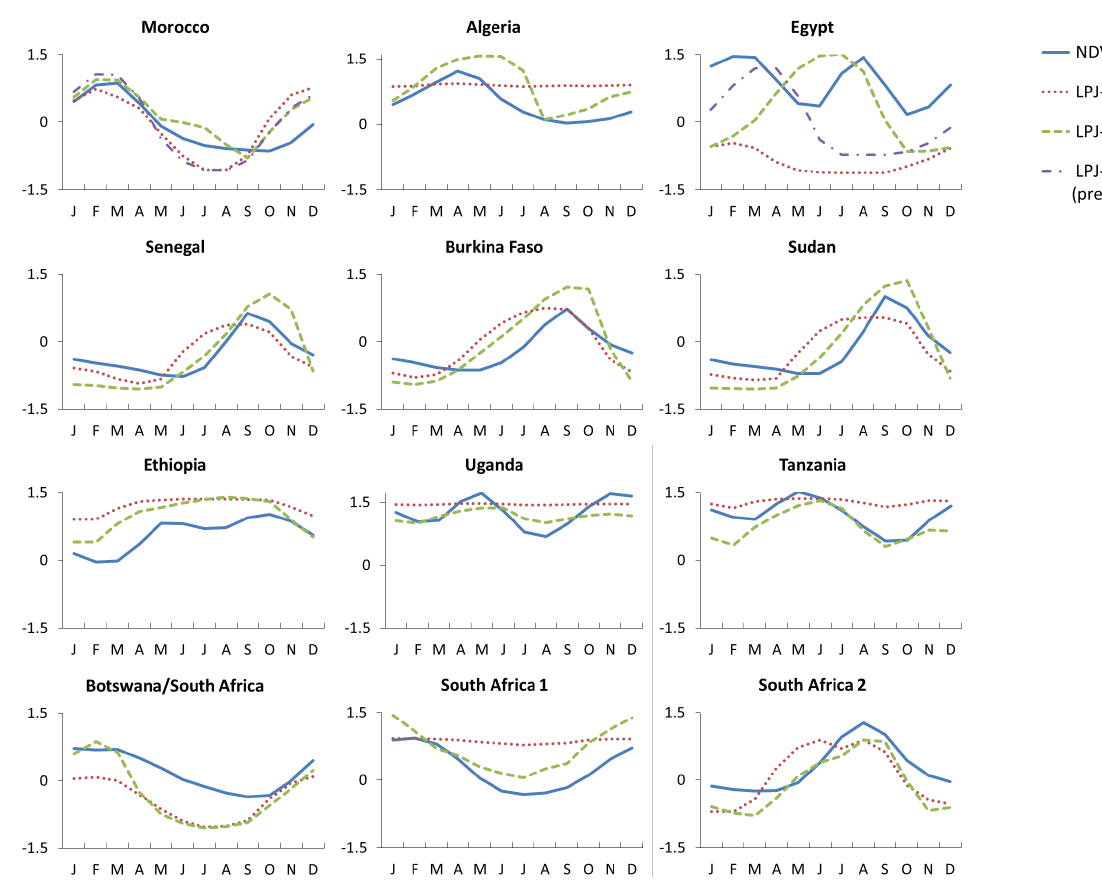
Fig. 5. Standardised anomalies (average for 4–15 adjacent cells, see Table 4 for details) of monthly observed NDVI and FPAR, modelled by LPJ-GUESS with and without land use (LU) functionality, relative to the African total mean and standard deviation, for the period 1982– 2006. Simulation S0, “LPJ-GUESS”, represents potential natural vegetation only, while simulation S1.7, “LPJ-GUESS LU”, represents potential natural vegetation plus cropland and pasture. Cropland is simulated without cover crop grass. For the Moroccan and Egyptian sites, an alternative sowing regime for irrigated crops is indicated (precipitation-dependent